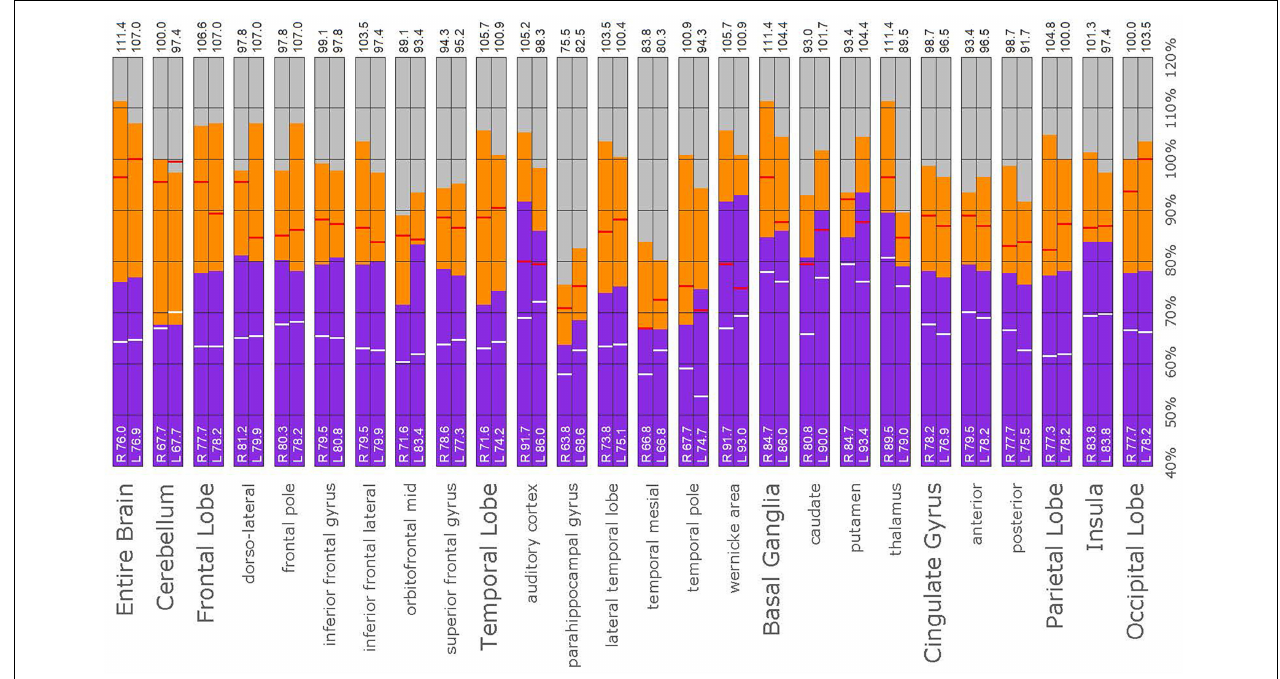
FIGURE 14 | Semi-quantitative region of interest analysis of the SPECT scan of Patient E. Data analysis and presentation is as described in Figure 10 . Thalamic perfusion exceeds the cerebellar maximum with marked asymmetry. Multiple cortical areas show asymmetrical and highly elevated perfusion exceeding the maximum in the cerebellum. Perfusion in the caudates and putamina is also elevated. In all ROI, with the exception of the cerebellum, the patient’s maximal counts exceed that of the normative sample (red line). In all ROIs, with the exception of the cerebellum, the patient’s median counts exceed that of the normative sample (white